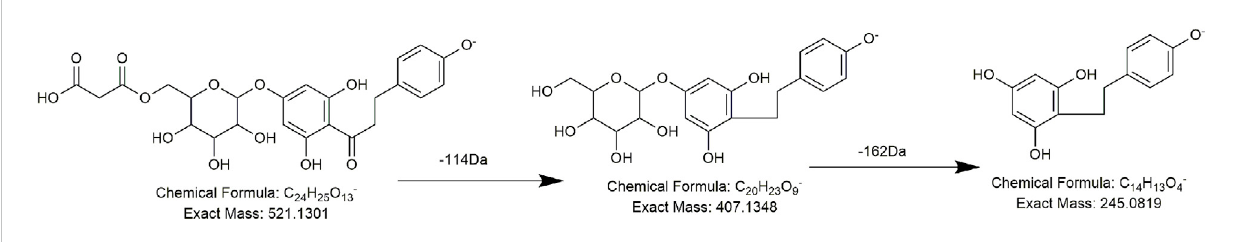
FIGURE 8 Proposed fragmentation pathways of compound FL21 (new compound-4).